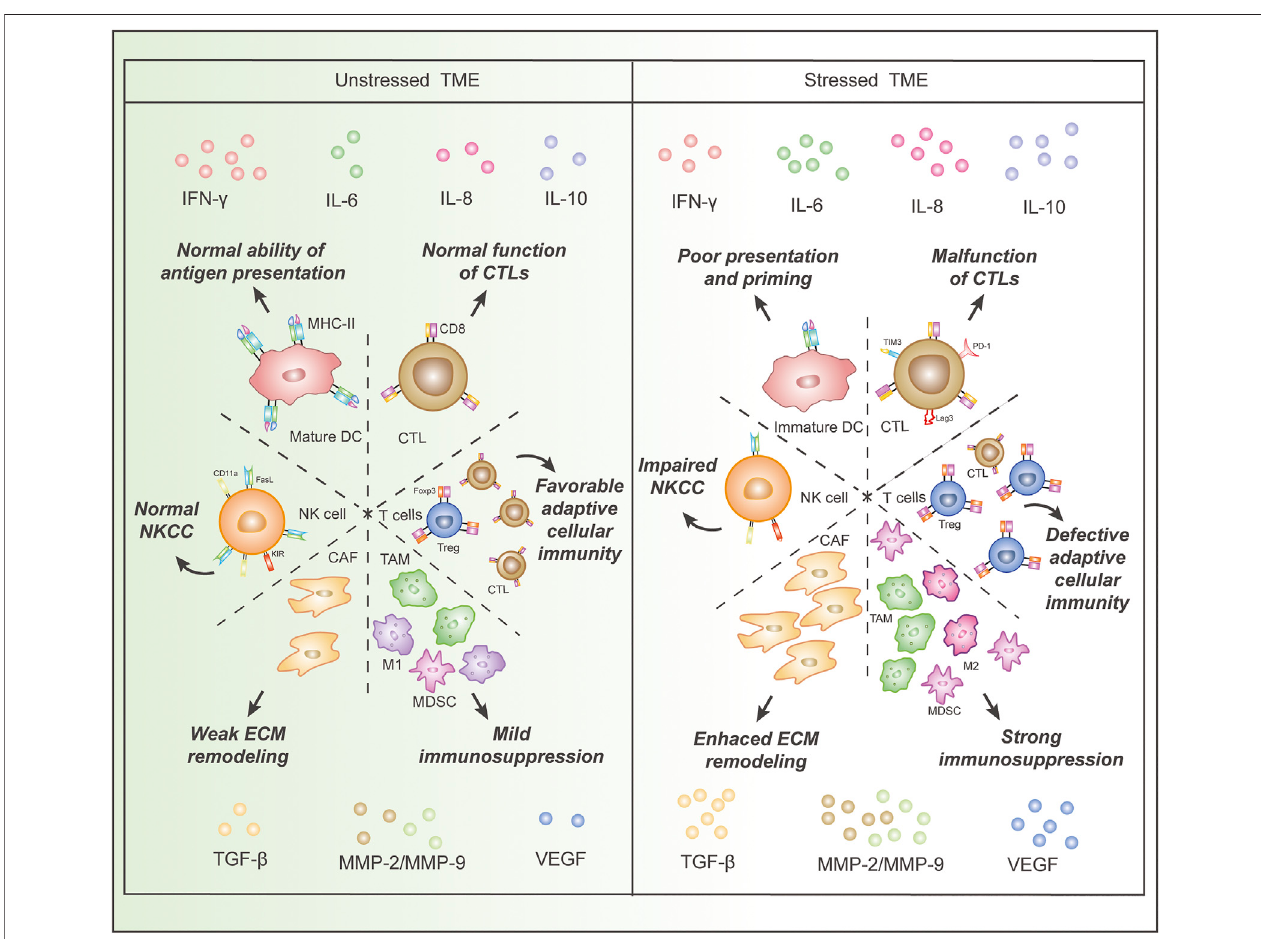
FIGURE 1 | Comparison of immune cells and cytokines in the stressed and unstressed tumor microenvironment (TME). Stressed TME is characterized by (I), decreased proportion and dysfunction of immune-supportive cells, including DCs and CTLs, as well as an increased proportion of cancer-promoting cells, such as MDSCs, Treg cells, CAFs, TAMs, and M2 macrophages; (II), increased concentrations of cytokines that impair anti-cancer immunity and induce angiogenesis, epithelial-mesenchymal transition, and extracellular matrix damage, as well as a decreased concentration of IFN- γ . Abbreviations: IFN, interferon; MMP, matrix metalloproteinase; IL, interleukin; TGF, transforming growth factor; VEGF, vascular endothelial growth factor; DC, dendritic cell; CTL, cytotoxic T lymphocyte, CAF, cancer-associated fi broblast; Treg, regulatory T cell; MDSC, myeloid-derived suppressor cell; TAM, tumor-associated macrophage;NK cell, natural killer cell; FasL, Fas ligand; NKCC, NK cell cytotoxicity; ECM, extracellular matrix.